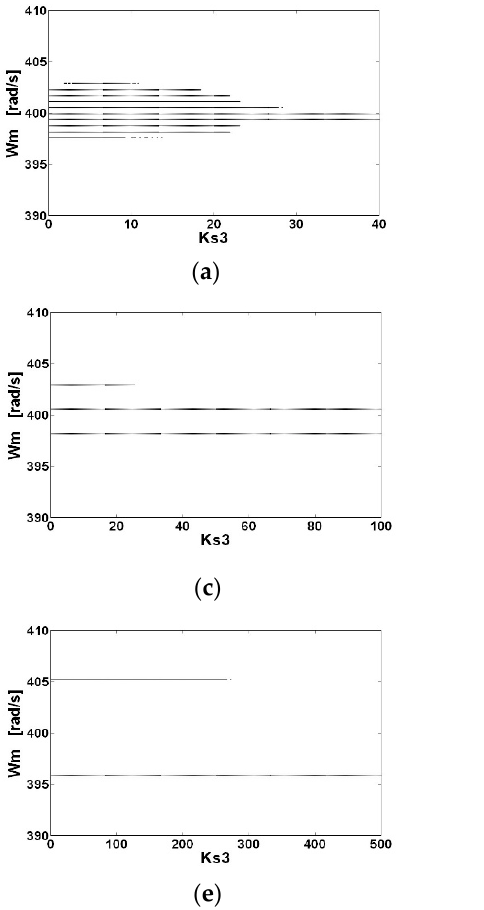
Figure 5. Numerical and experimental bifurcation diagrams for the speed of the motor 𝑊 (cid:3040) versus the control parameter 𝐾 (cid:3020)(cid:2871) . These diagrams are plotted considering the following quantization levels: ( a ) 𝑊 (cid:3040) with 28 bits, ADC with 12 bits, and 𝑑 with 10 bits; ( b ) 𝑊 (cid:3040) with 28 bits, ADC with 12 bits, and 𝑑 with 10 bits; W m with 28 bits, ADC with 12 bits, and d with 10 bits; ( b ) W m with 28 bits, ADC with 12 bits, and d ( c ) 𝑊 (cid:3040) with 26 bits, ADC with 10 bits, and 𝑑 with 8 bits; ( d ) 𝑊 (cid:3040) with 26 bits, ADC with 10 bits, and 𝑑 with with 10 bits; ( c ) W m with 26 bits, ADC with 10 bits, and d with 8 bits; ( d ) W m with 26 bits, ADC with 10 8 bits; ( e ) 𝑊 (cid:3040) with 24 bits, ADC with 8 bits, and 𝑑 with 6 bits; and ( f ) 𝑊 (cid:3040) with 24 bits, ADC with 8 bits, and bits, and d with 8 bits; ( e ) W m with 24 bits, ADC with 8 bits, and d with 6 bits; and ( f ) W m with 24 bits, 𝑑 with 6 bits. ADC with 8 bits, and d with 6